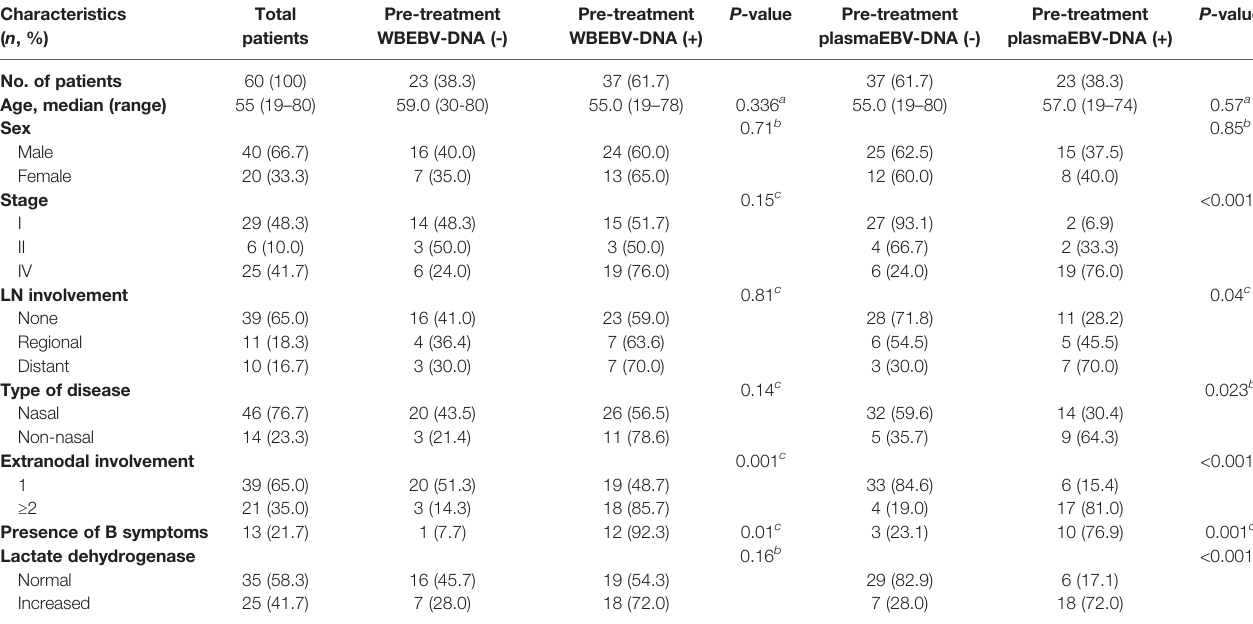
TABLE 1 | Clinicopathological characteristics of patients at diagnosis according to the status of whole blood and plasma Epstein-Barr virus (EBV)-DNA (n = 60). Characteristics ( n ,